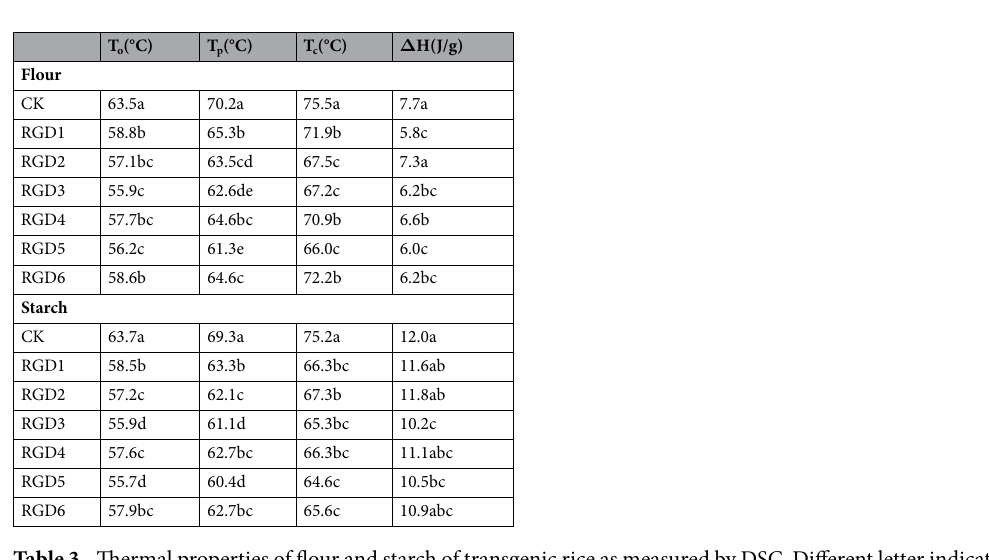
Table 3. Thermal properties of flour and starch of transgenic rice as measured by DSC. Different letter indicates significant difference (P < 0.05).